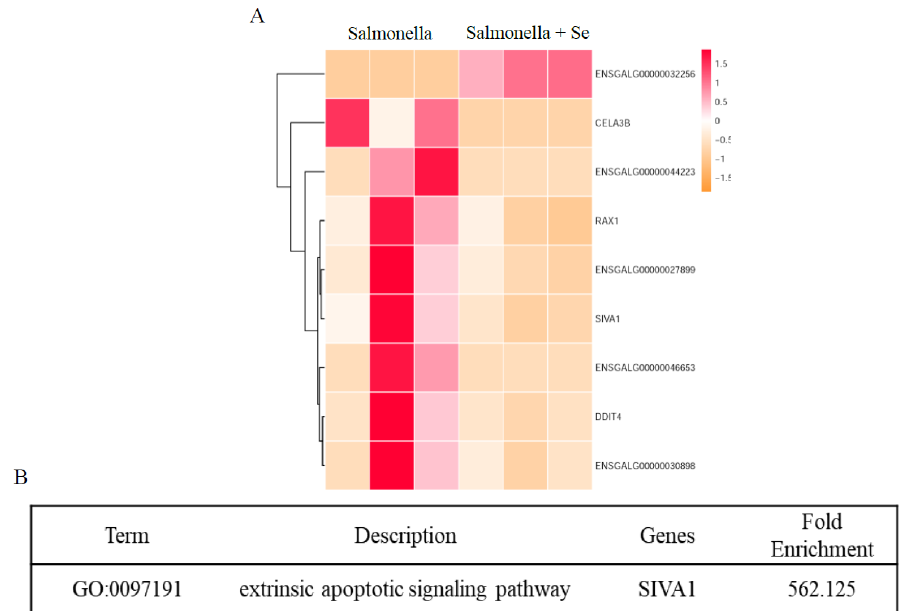
Figure 4. Selenium could inhibit the salmonella-induced macrophage apoptosis through an extrinsic apoptotic signaling pathway via SIVA1 . ( A ) The expression profiles of DEGs between the group infected with S. Pullorum C79-13 (BC: salmonella) and the group of macrophages infected with S. Pullorum C79-13 and treated with Se (sodium selenite) (BS: salmonella + Se). ( B ) The major over- represented GO terms of differentially expressed genes between the group infected with S.